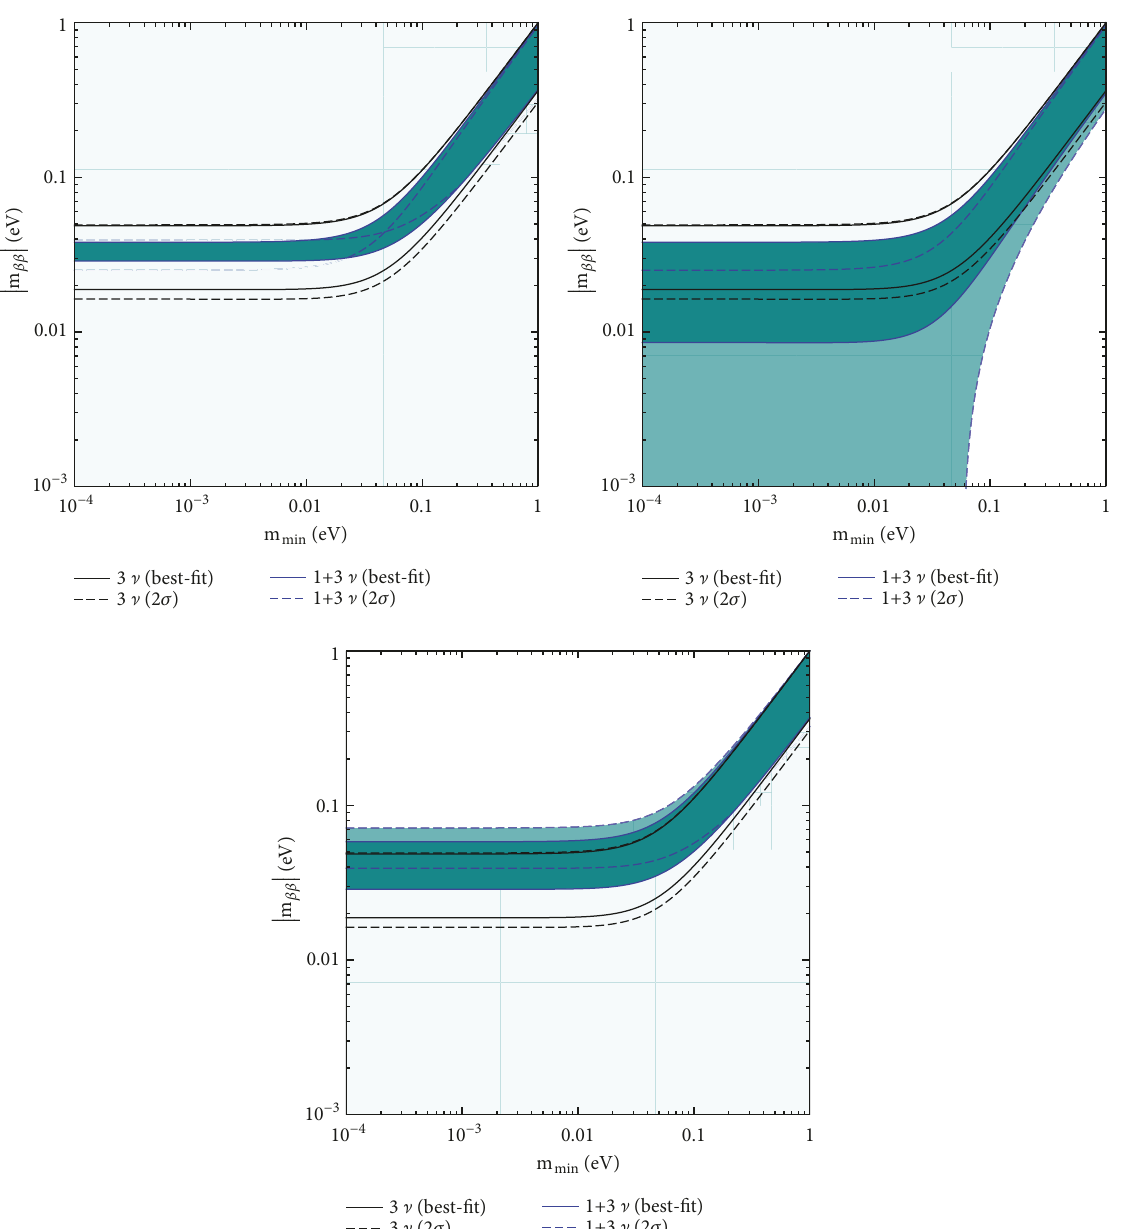
Figure 5: The allowed ranges in the |𝑚 𝛽𝛽 | - 𝑚 𝑙𝑜𝑤 parameter space, both in the standard three-neutrino picture and with one sterile neutrino for the 3+1 IO case. Top left panel upper and lower band range are obtained in the mass term combination of (+,+,-) and (-,-,+), while right panel upper and lower band range are obtained in the mass term combination of (+,+,-) and (-,-,-). Bottom upper and lower band range are obtained in the mass term combination of (+,+,+) and (-,-,+). The signs indicate the signs of 𝑒 𝑖𝛼 21 ,𝑒 𝑖𝛼 31󸀠 ,𝑒 𝑖𝛼 41 = ± 1; these are the extreme cases which determine the minimum and maximum value of |𝑚 𝛽𝛽 | in which CP is